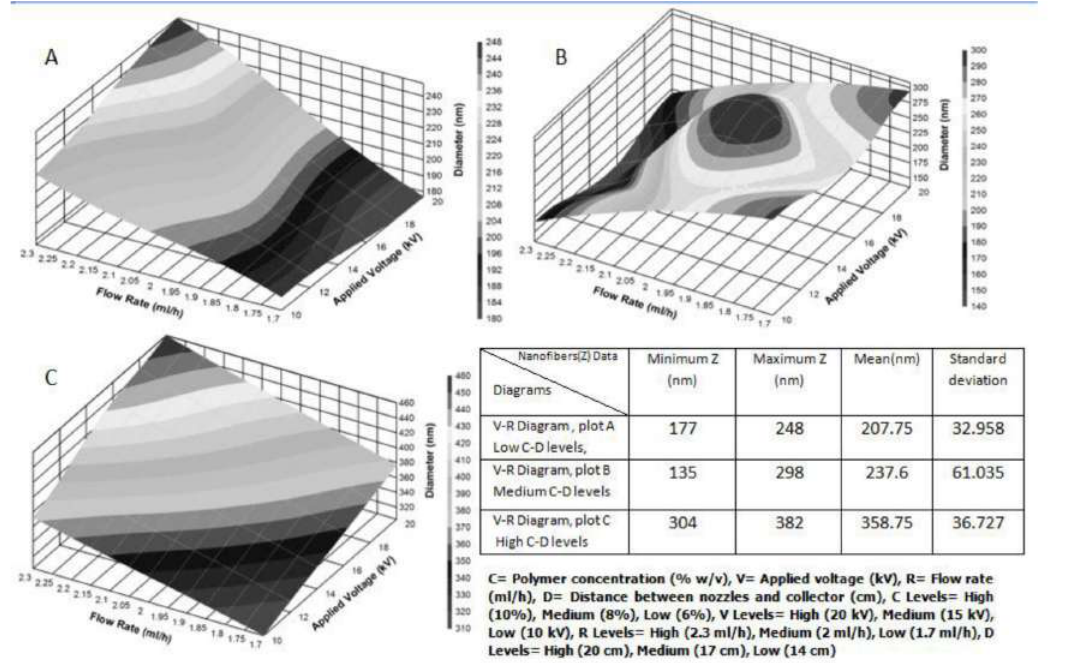
Fig. 6. The data and 3 D plots of nanofibers diameter predicted by ANN fixed in mentioned levels (V-R